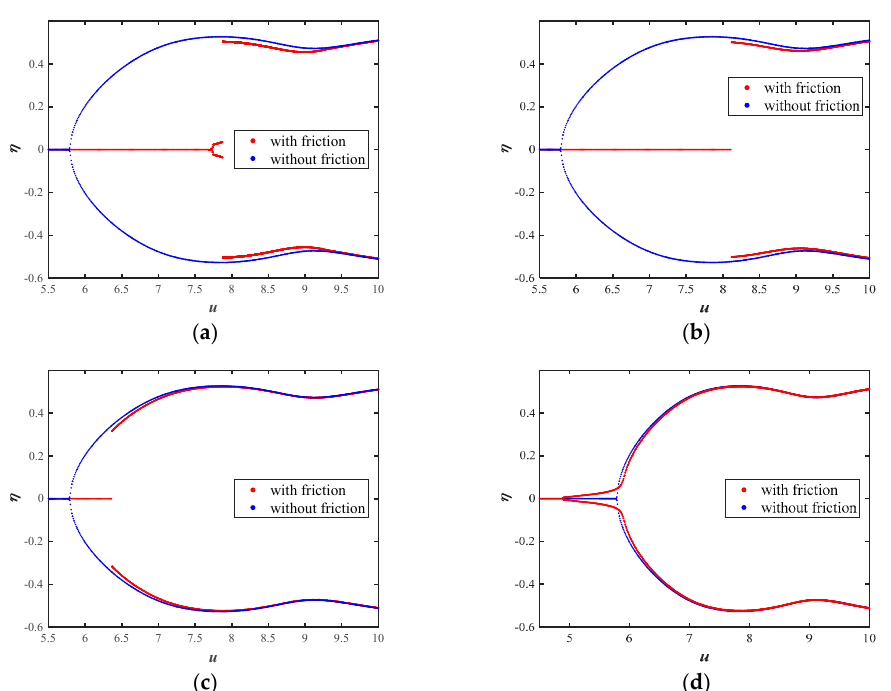
Figure 6. Bifurcation diagrams for the tip − end responses of the pipe for different installation positions, with α = 0.001, β = 0.213, and f n = 0.5: ( a ) ξ d = 0.3; ( b ) ξ d = 0.5; ( c ) ξ d = 0.7; ( d ) ξ d = 0.9.